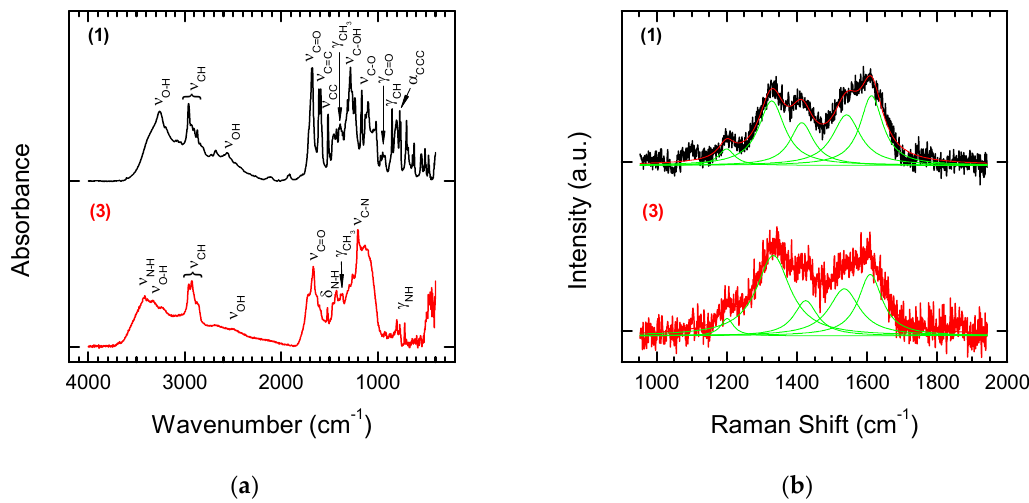
Figure 6. FT-IR ( a ) and Raman spectra ( b ) of NDPs 1 (upper panel) and after coupling with methyl ester of 6-aminohexanoic acid 3 (lower panel).